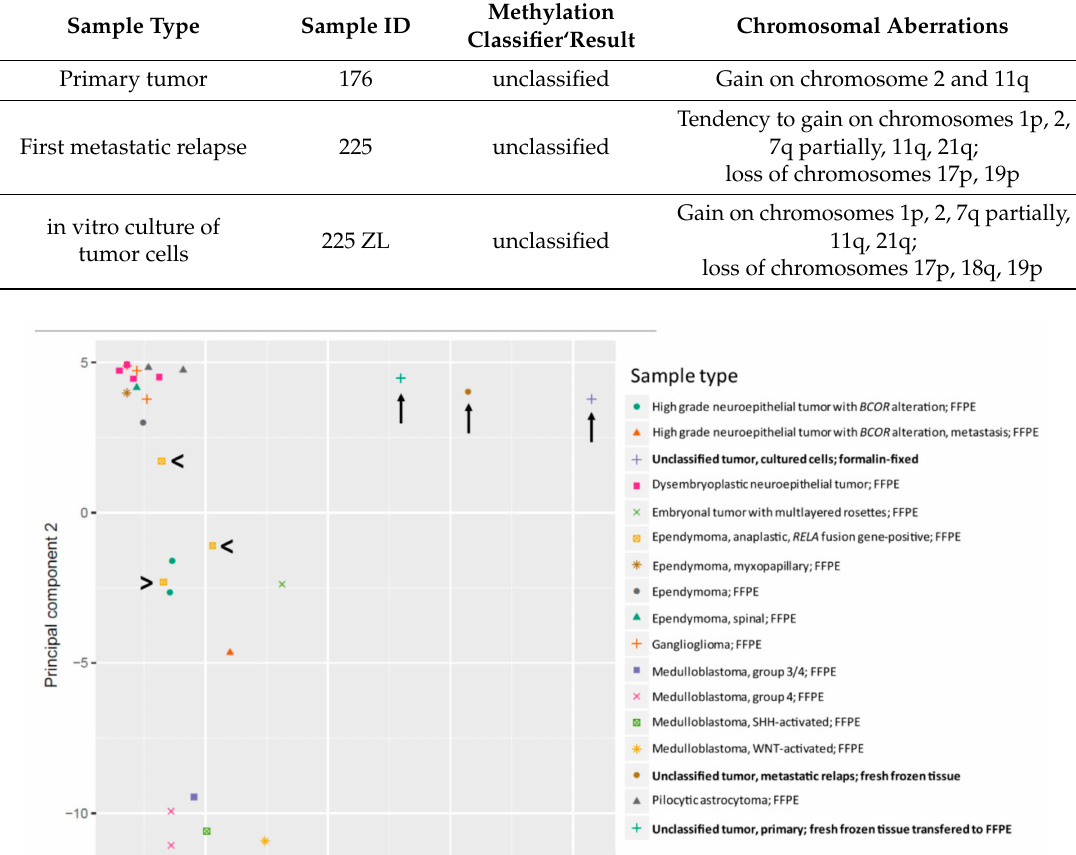
Table 1. Results of the methylation classifier and summary of the chromosomal aberrations.